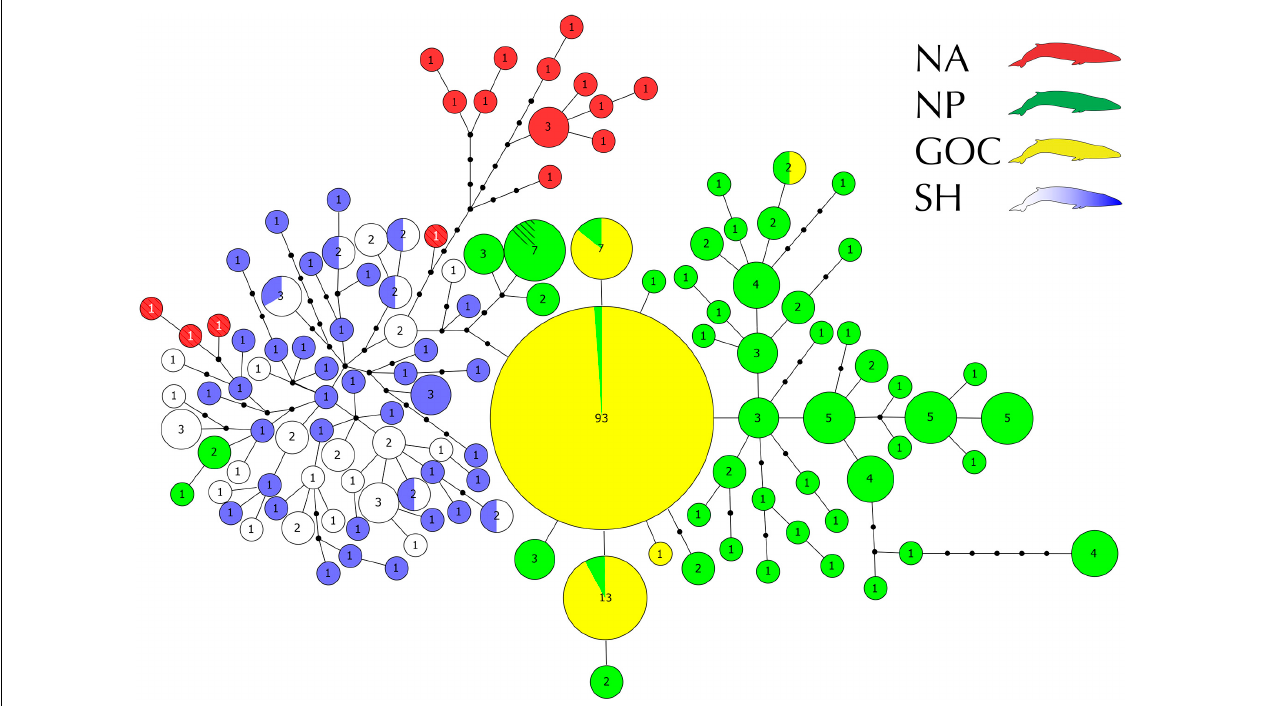
FIGURE 2 | Global haplotype network of the 305 control region sequences constructed in Hapview. Localities are color coded as follows: North Pacific (green), Gulf of California (yellow), North Atlantic (red), Southern Ocean (blue) and southeastern Pacific (white). Circle size is proportional to the frequency, detailed within each haplotype. Black dots indicate one mutational step. The hatched haplotypes (four from NA red with white numbers and one from NP) were retrieved from Cabrera et al. (2019), their frequencies were not